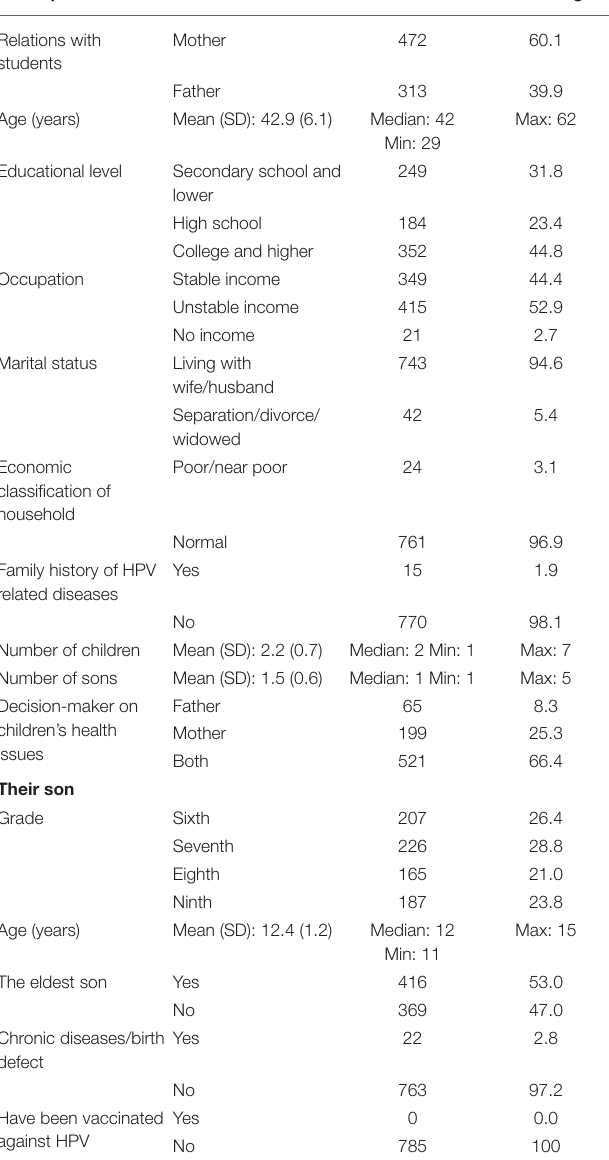
TABLE 1 | Characteristics of participants and their sons ( n = 785). TABLE 2 | Knowledge about Human papilloma virus (HPV) and HPV vaccine of the parents ( n =